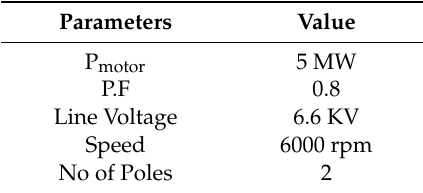
Table 2. Induction motor